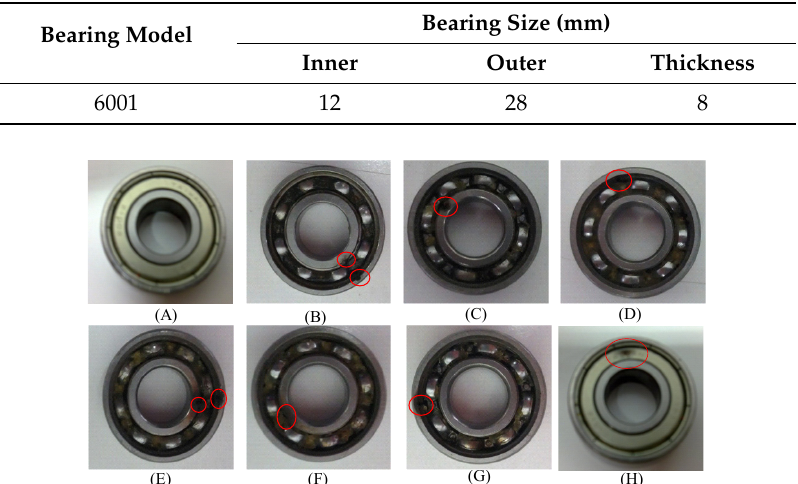
Figure 6. ( A ) Healthy bearing, ( B ) 1.0 mm holes on both inner and outer race, ( C ) one 1.0 mm hole on inner race, ( D ) one 1.0 mm hole on outer race, ( E ) 0.5 mm holes on both inner and outer race, ( F ) one